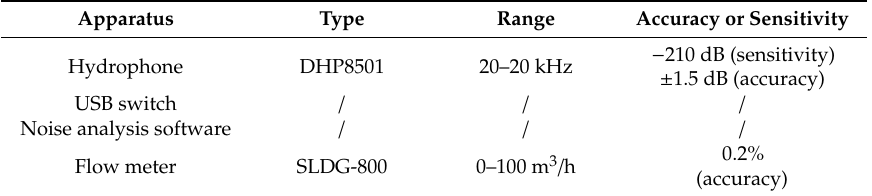
Table 3. Performance characteristics of apparatuses.